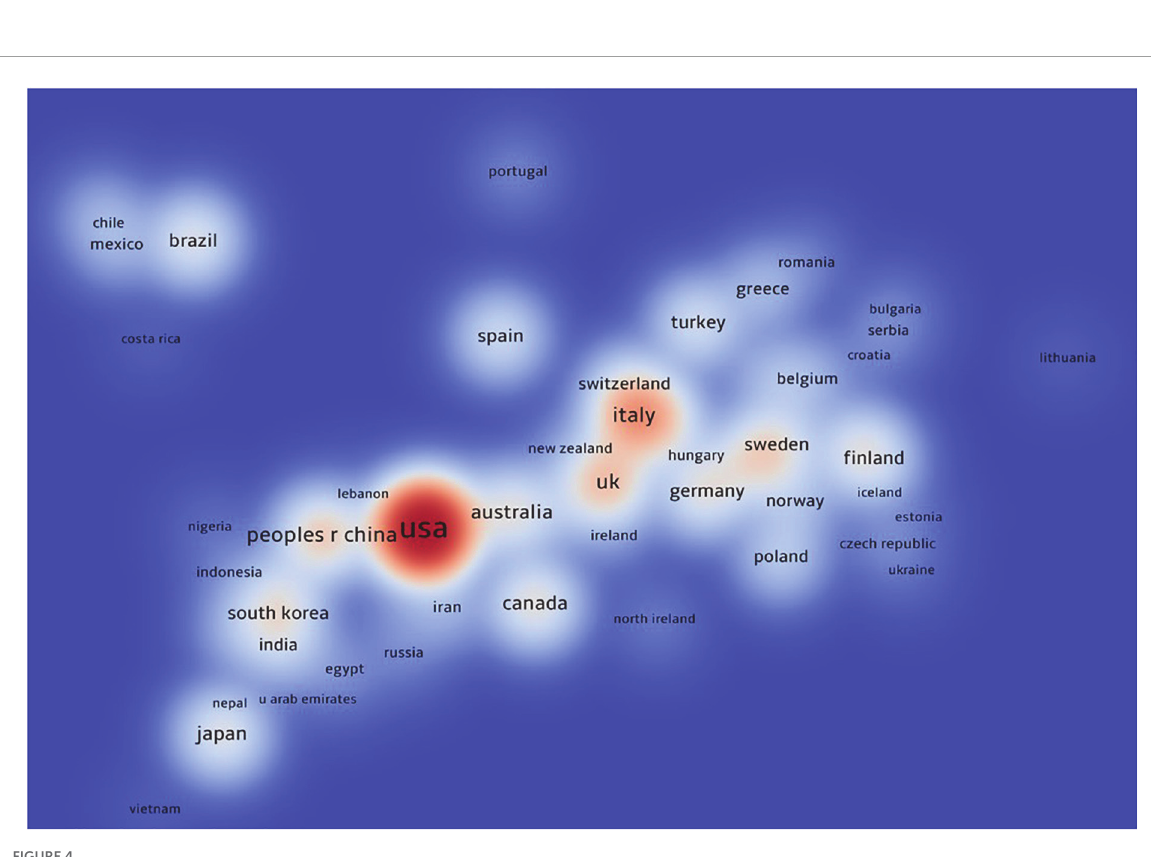
FIGURE4 Map of Countries that published menopausal hormone therapy (MHT)-related